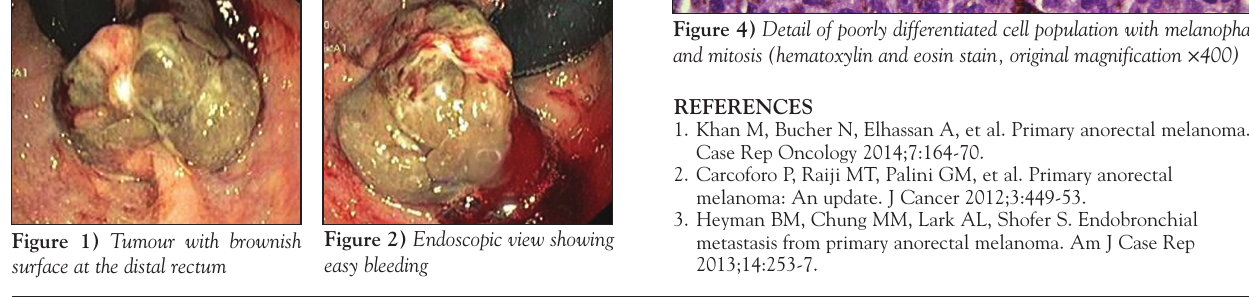
Figure 1) Tumour with brownish surface at the distal